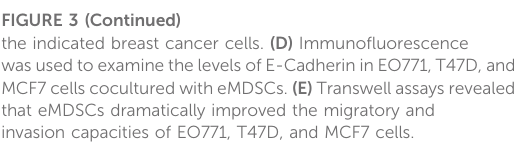
FIGURE 3 eMDSCs promote migration and invasion of luminal A breast cancer cells via stimulating EMT (A) KEGG enrichment analysis of the differential expressed genes between eMDSCs high and eMDSCs low groupsdividedbythe21-genessignatureinTCGA breast cancer cohort. (B) Distribution of FPKM values for TCGA breast cancer samples between eMDSCs high and eMDSCs low groups for the three EMT-related genes. (C) Immunoblotting was used to assess the proteins of E-Cadherin, Vimentin, and SNAIL in